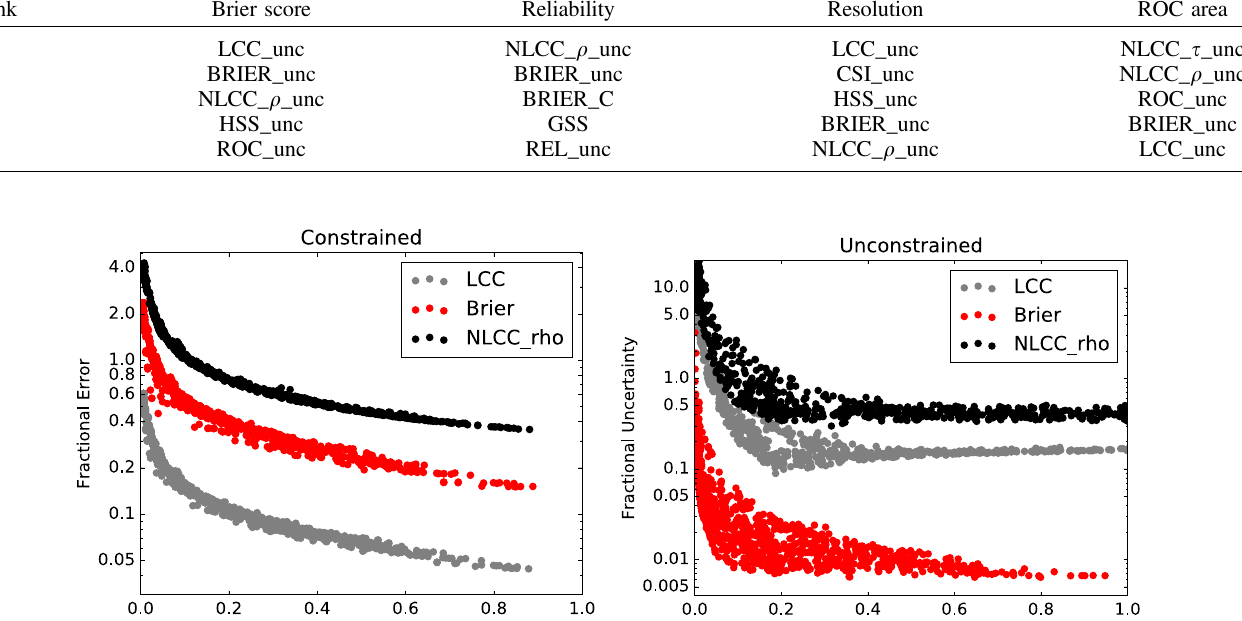
Fig. 7. Fractional uncertainties as a function of ensemble probability. Left and right panels compare the CLC and ULC cases for the three top- performing ensembles (Table 4 for M-class fl ares, consisting of the metrics linear correlation coef fi cient (LCC; grey), Brier score (Brier; red), and non-linear rank correlation coef fi cient, q (NLCC_ q ;